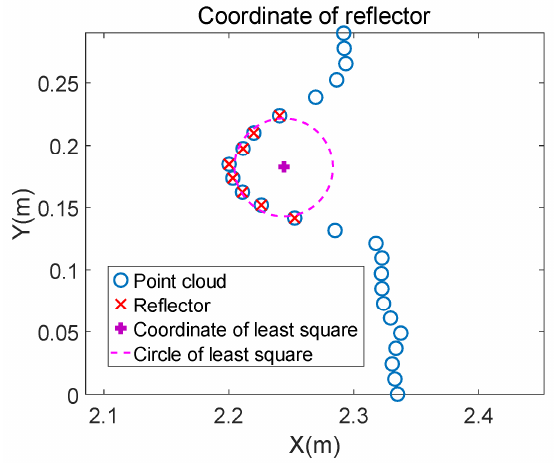
Figure 7. The reflector coordinate is fitted by the traditional least square method firstly. The fitted circle is still a certain distance from the line. It is necessary to modify the rough coordinate to get a more precise value.